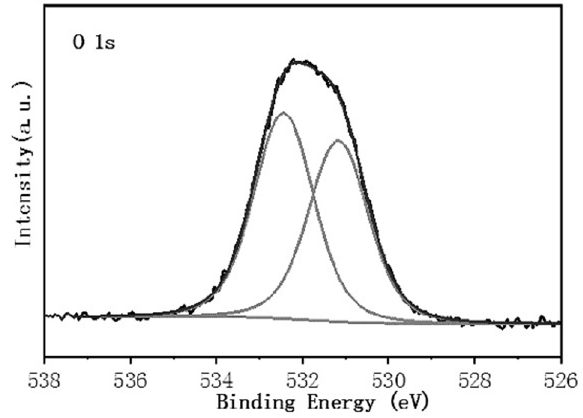
Figure 12. The O 1s spectrum disassembled into two peaks at 531.1 eV and 532.5 eV.